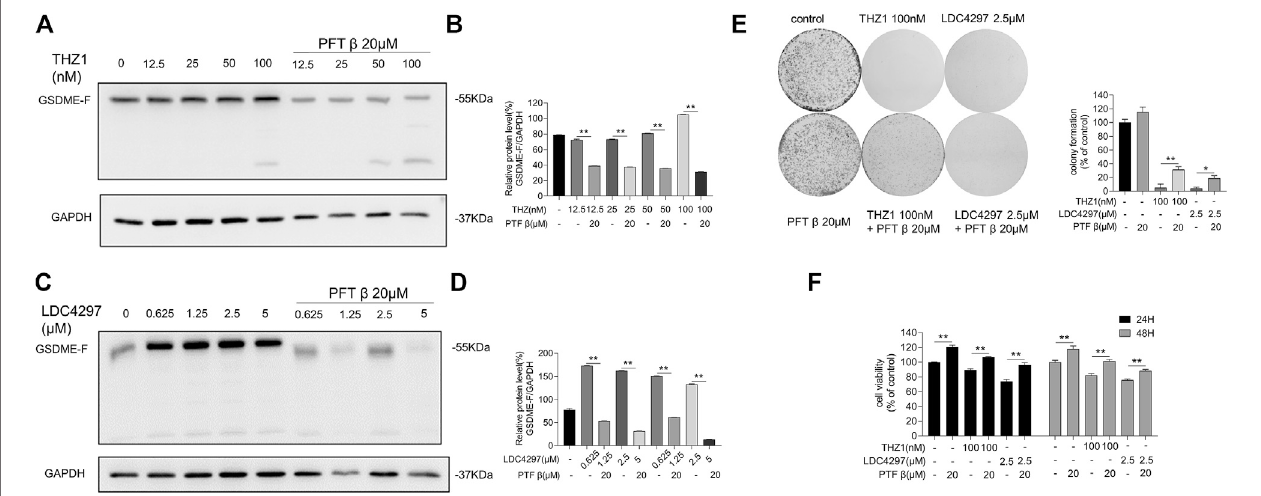
FIGURE 5 | p53 inhibitor blocked the anti-cancer effects of CDK7 inhibitors. (A) MCF-7 cells were fi rstly given PFT β for 6 h and then treated with THZ1 for 36 h. Westernblotwasusedtodisplay theGSDMEprotein level. (B) QuantityofGSDMEin (A) . (C) MCF-7cellswere fi rstlygivenPFT β for6 handthentreatedwithLDC4297 for 36 h. Western blot was used to display the GSDME protein level. (D) Quantity of GSDME in (C) . (E) The colony formation assay was performed to detect the colony formationabilityofMCF-7cellsgivenPFT β for6 hbeforetreatedwithTHZ1orLDC4297. (F) MCF-7cellswere fi rstlygivenPFT β for6 handthentreatedwithTHZ1 or LDC for 24 or 48 h separately. The CCK8 assay was used to measure the MCF-7 cell viability. Statistically signi fi cant: * p < 0.05; ** p <